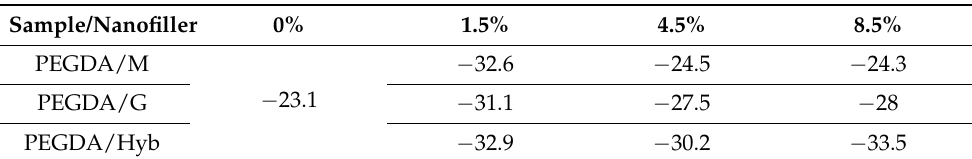
Table 3. T g (°C) of Neat PEGDA, and composites PEGDA/G, PEGDA/M and PEGDA/Hyb for dif- ferent percentages of nanofillers obtained by DMA.